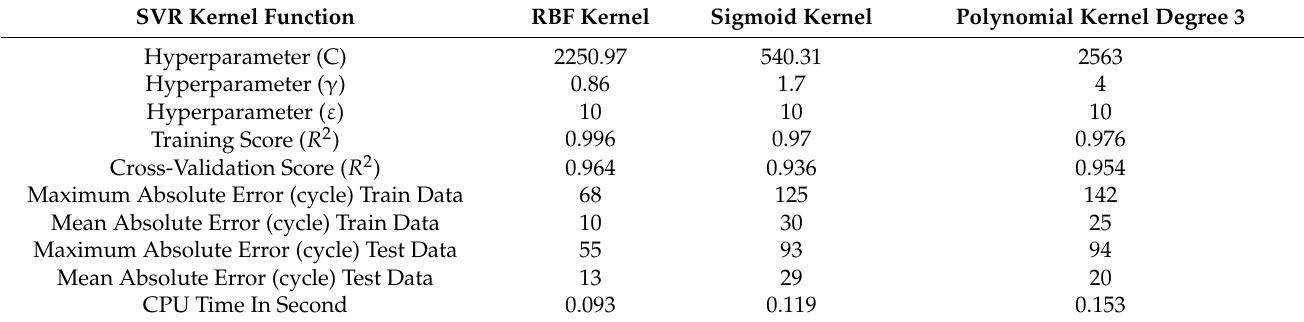
Table 14. Comparison results of FEM and SVR models on 576 training datasets.